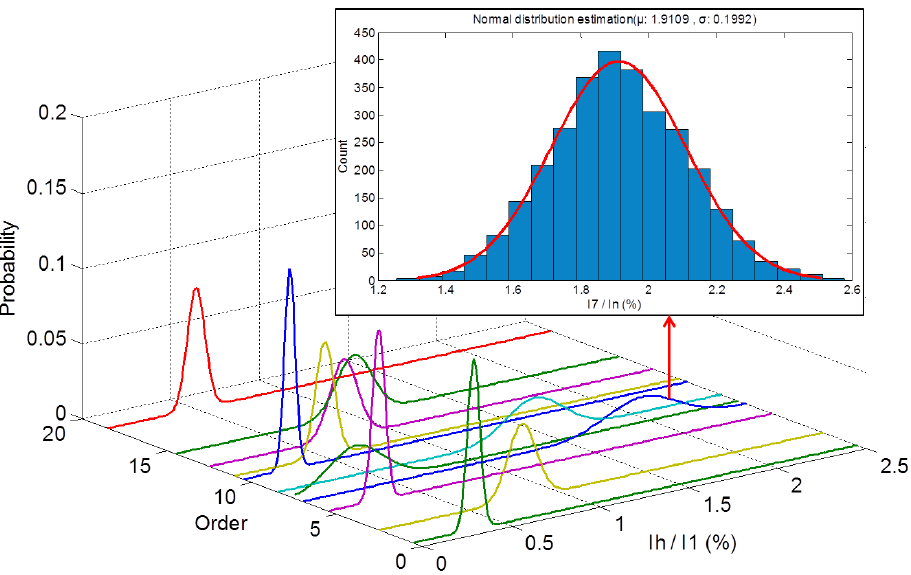
Figure 7. Approximated PDFs of the harmonic currents from a WT and the histogram of the seventh order harmonic based on the simulation results.